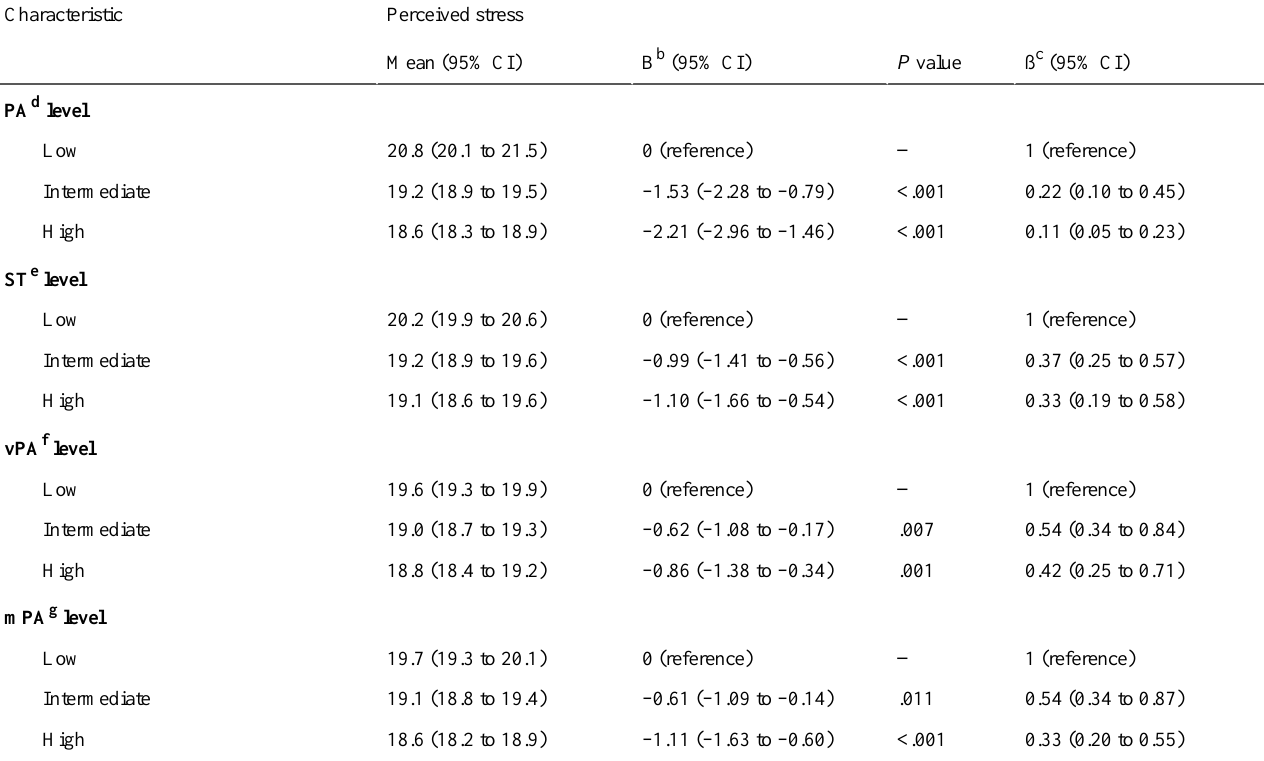
Table 2. Independent associations of physical activity levels, sedentary time, and perceived stress a